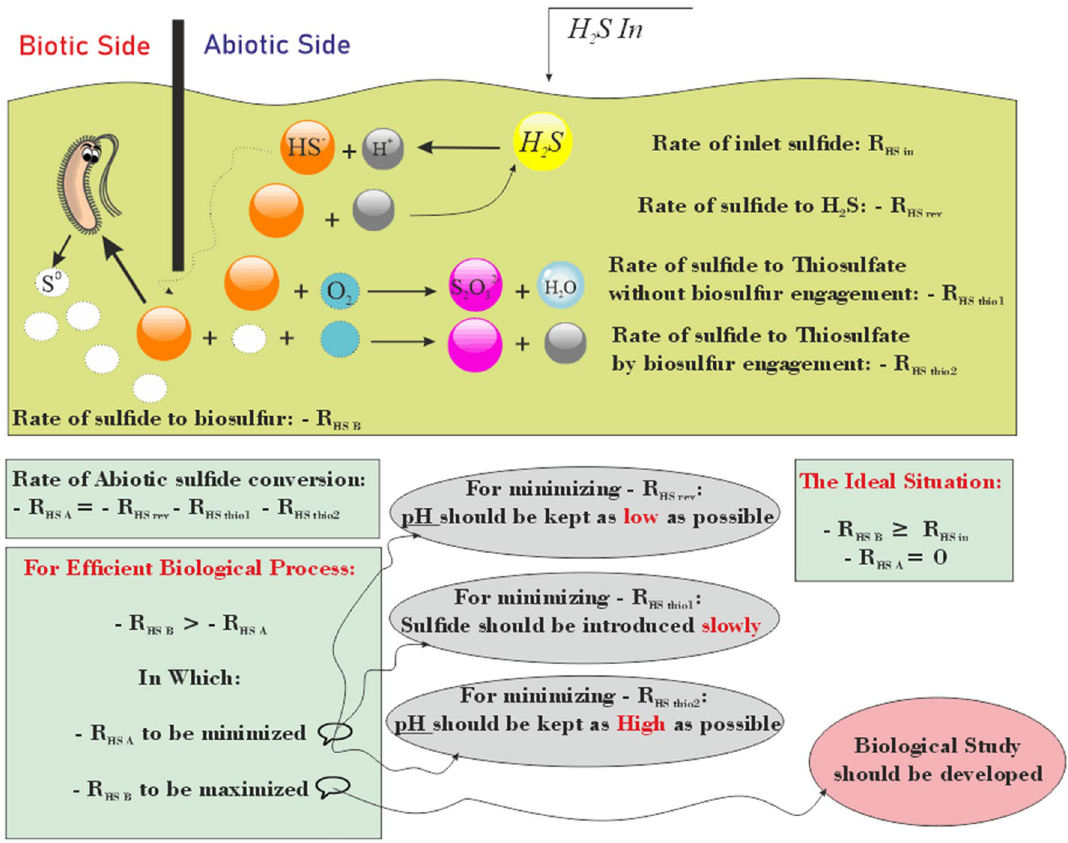
Figure 12. Summery of findings on abiotic side of gas